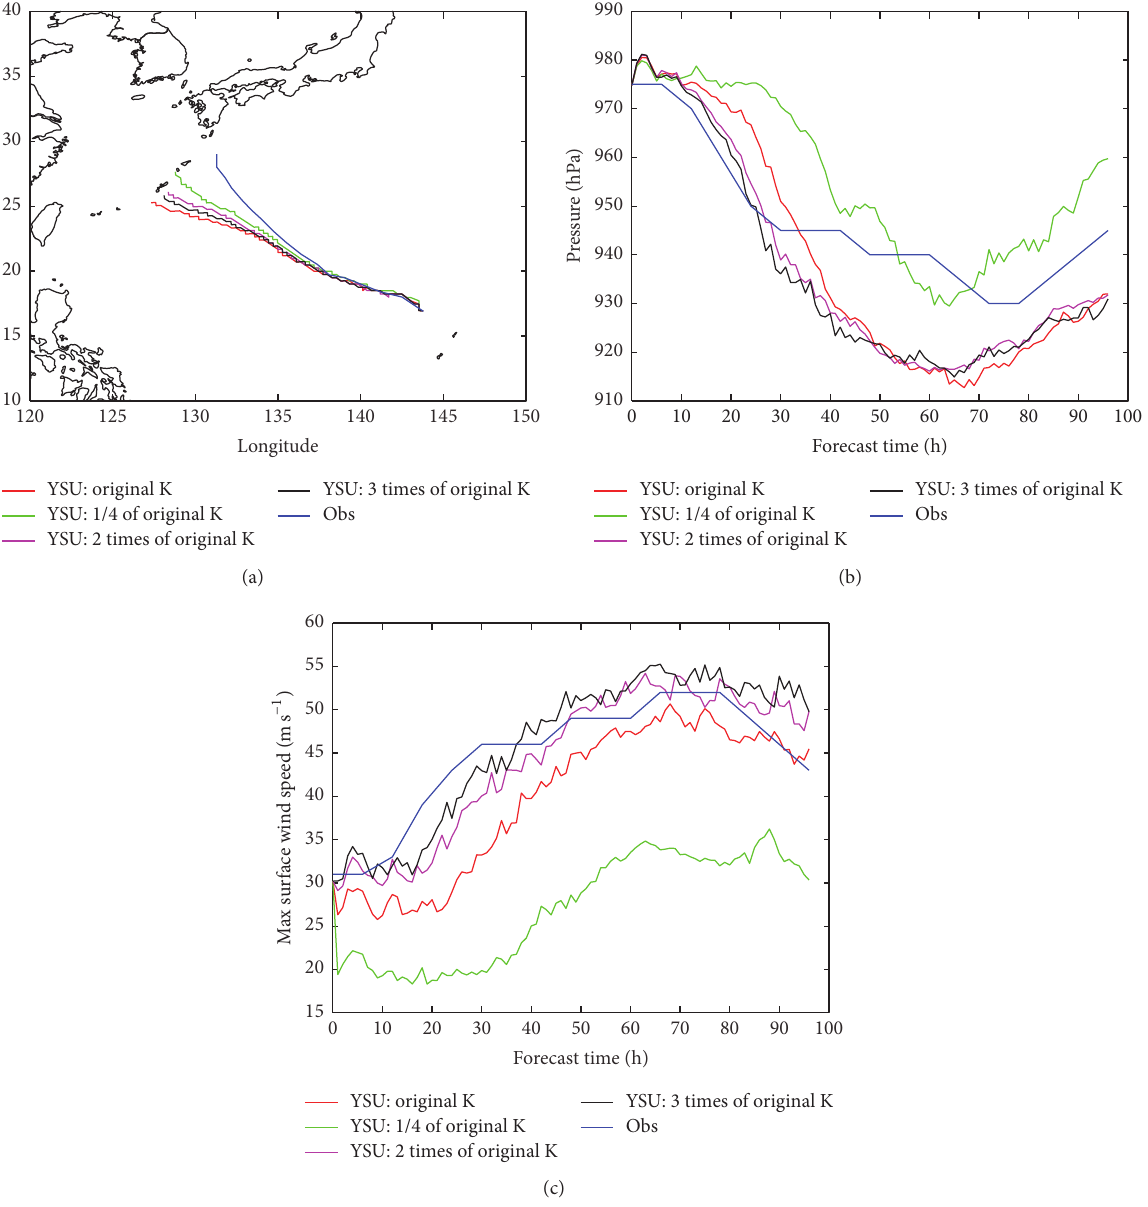
Figure 9: Track, CSLP, and MWSP of super typhoon Phanfone (2014) simulated by the original YSU, the K025, the K200, and the